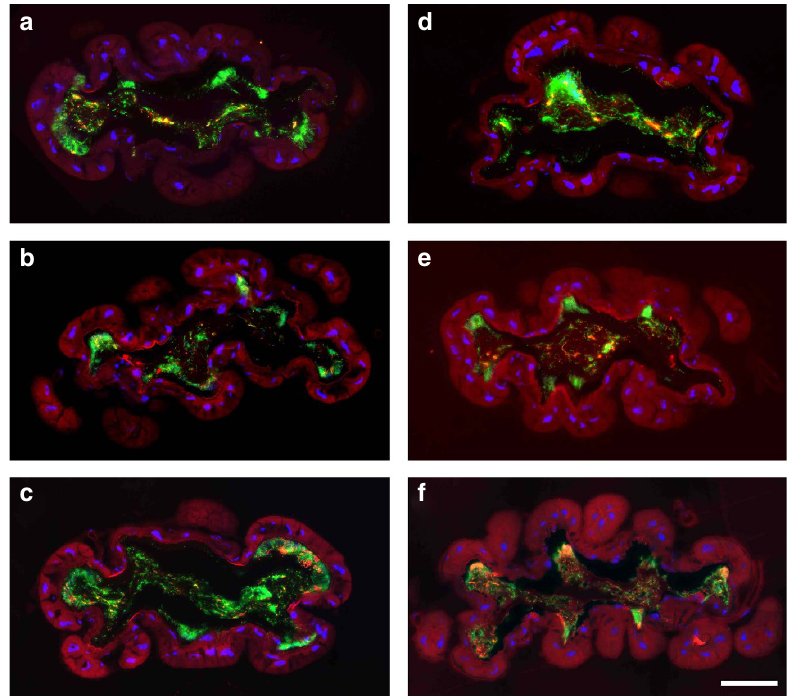
Figure 5 | Localization of major bacterial taxa in the hindgut of an N. vespilloides adult female by fluorescence in situ hybridization. Bacteria were stained with the general bacterial probe EUB338-Cy5 (green) and taxon-specific Cy3-labelled oligonucleotide probes (red). Nuclei were counterstained with 4,6-diamidino-2-phenylindole (DAPI; blue). ( a ) Vagococcus , ( b ) Tissierella , ( c ) Xanthomonadaceae, ( d ) Morganella , ( e ) Providencia and ( f ) Proteus . Scale bar, 100 m